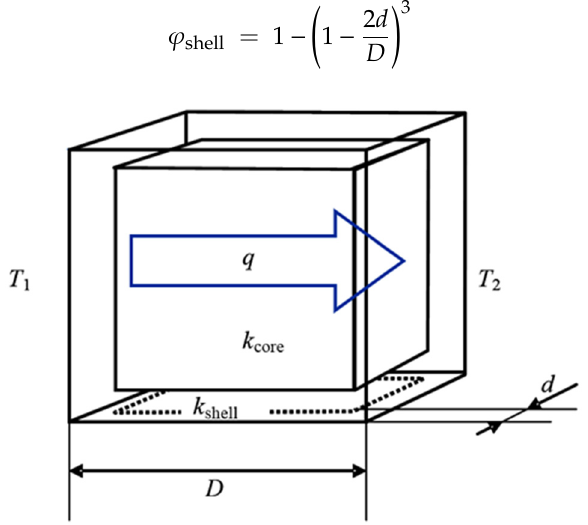
Figure 1. Simplified model of the core-shell filler grain. The heat flow q runs from the left wall, of temperature T 1 , to the right one, of the temperature T 2 . In case the thermal conductivity of the shell is much larger than that of the core, the heat flux is transported on the major part through the shell material and on the smaller part, in parallel, through the core (parallel model). The part transported through the core meets on its path the core material of thickness 𝐷 − 2𝑑 and that of the shell of thickness of 2𝑑 (series model).